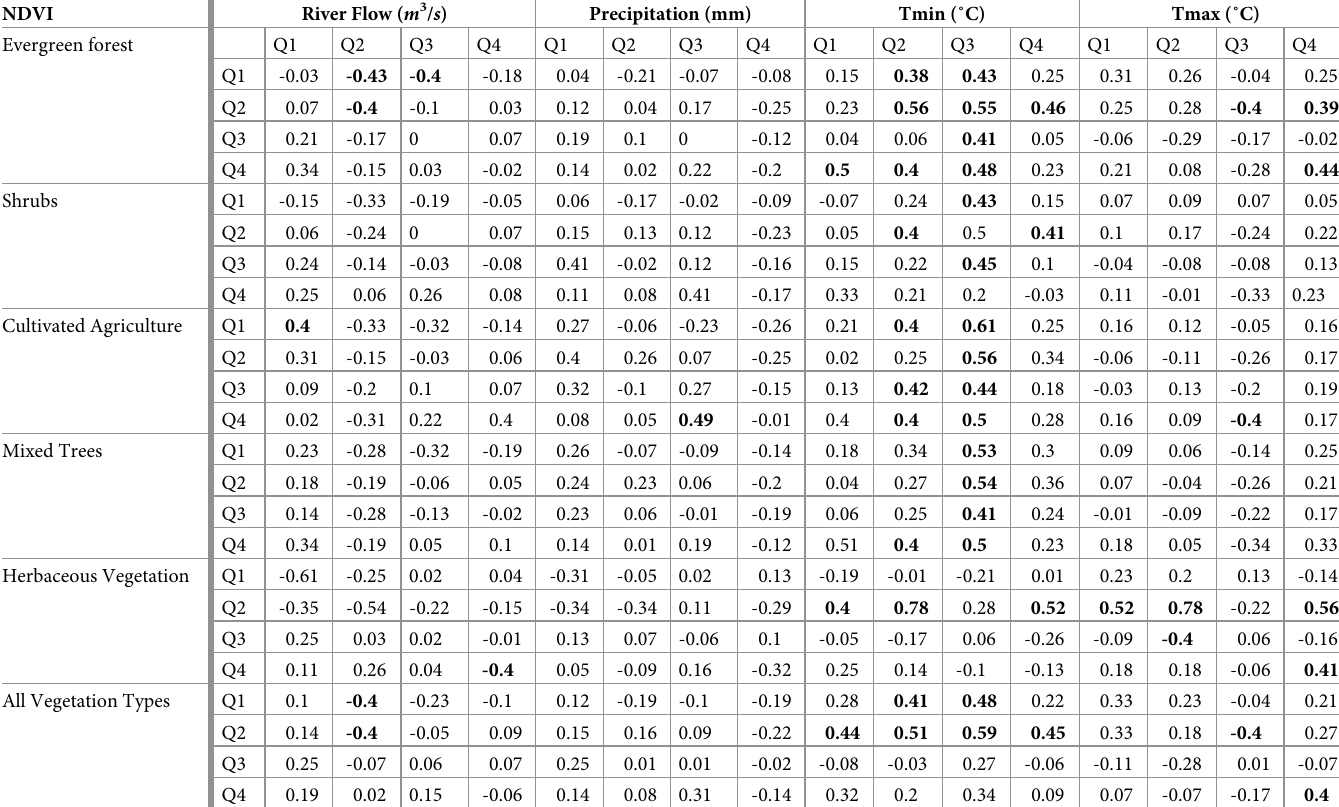
Table 5. Seasonal correlation of NDVI of vegetation classes with climatic variables in each quarter over the UJRB. NDVI River Flow ( m 3 / s ) Evergreen forest